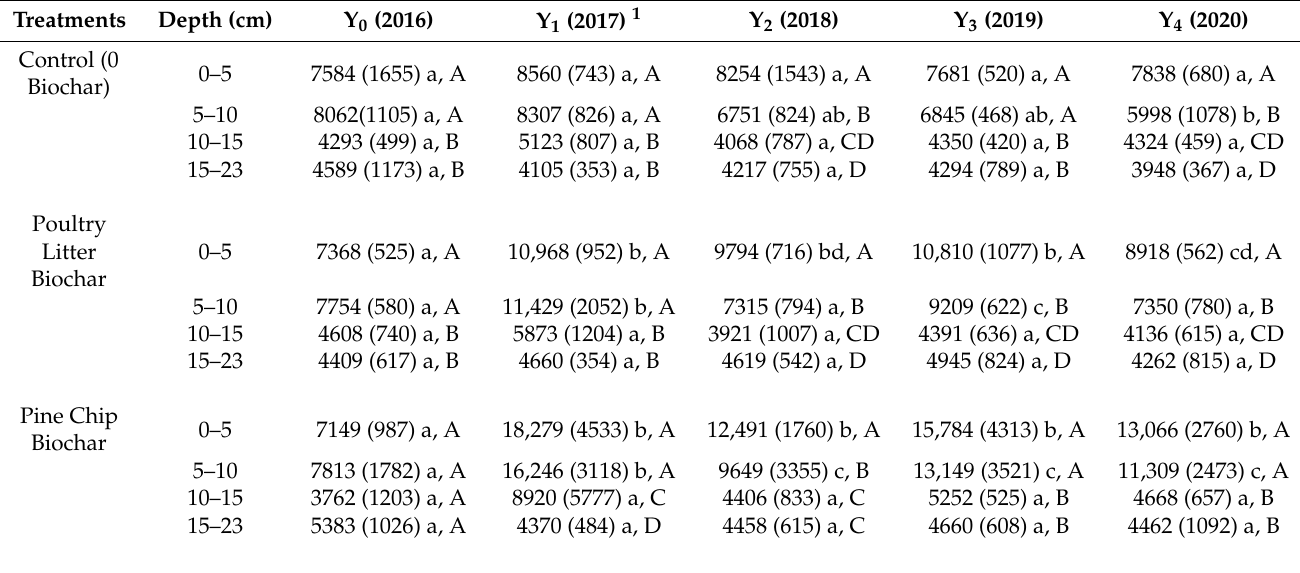
Table 4. Annual mean soil organic carbon contents (kg ha − 1 ) by depth in Controls (0 biochar), in Poultry litter and Pine chip biochar treated plots ( n = 4, standard deviations in parentheses, 2016 results represent background contents and not used in statistical